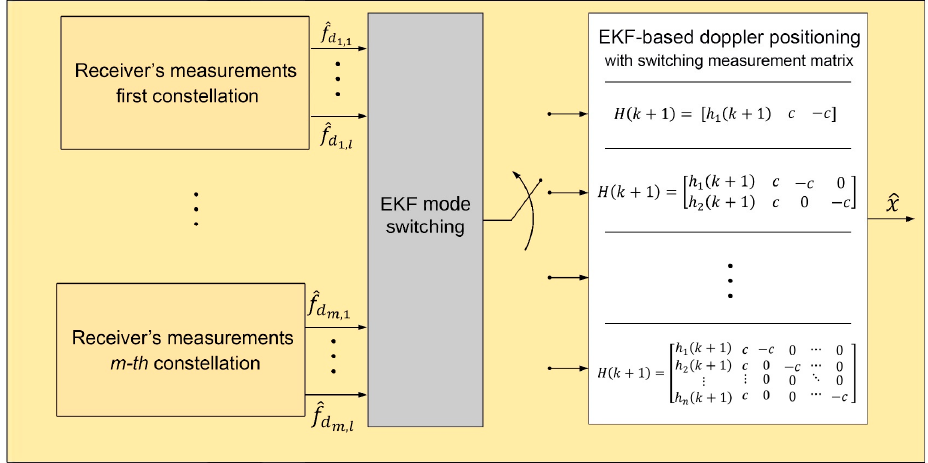
Figure 2. Architecture of proposed multi-constellation LEO satellite receiver.